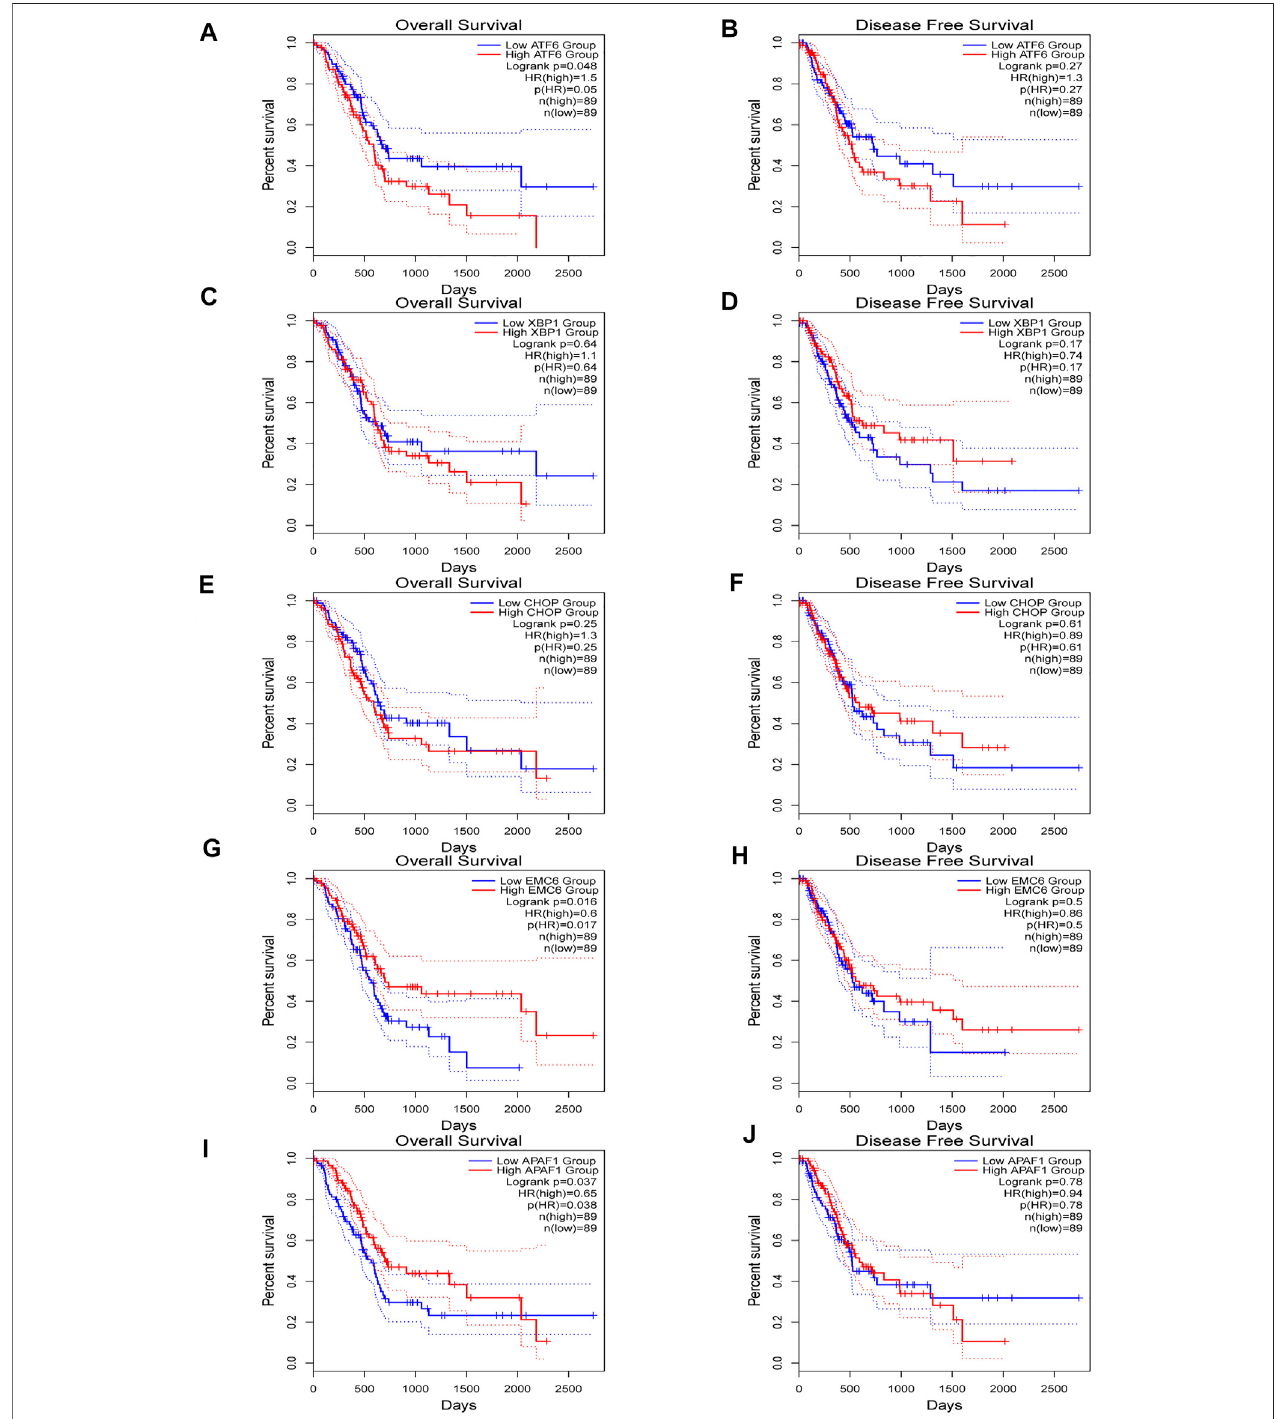
FIGURE 2 | Kaplan – Meier plotter for overall survival (OS) (A,C,E,G,I) and disease-free survival (DFS) (B,D,F,H,J) based ATF6, XBP1, CHOP, EMC6, or APAF1 expression via survival analysis in GEPIA2 database. The two-sided log-rank test was performed to compare differences by p -values.